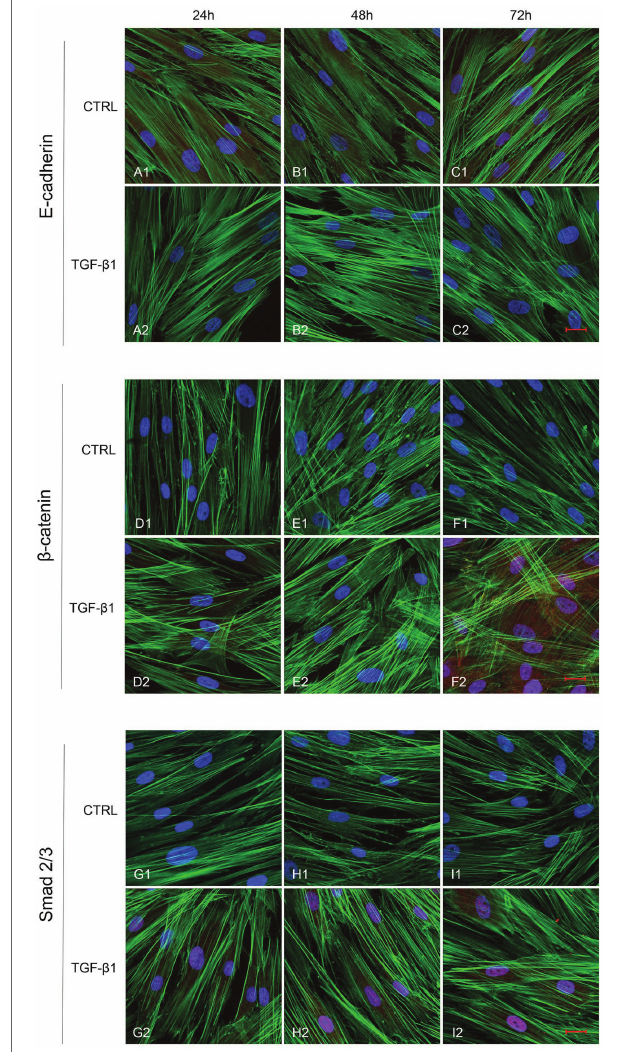
FIGURE 5 | Human GFs uninduced and induced with TGF- β 1 (10 ng/ml) were observed after 24, 48, and 72 h incubation. E-cadherin specific marker evaluation in untreated (A1-C1) and TGF- β 1 treated cells (A2-C2) . β -catenin specific marker evaluation in untreated (D1-F1) and TGF- β 1 treated cells (D2-F2) . Smad 2/3 specific marker evaluation in untreated (G1-I1) and TGF- β 1 treated cells (G2-I2) . Red fluorescence: specific marker; green fluorescence: cytoskeleton actin; blue fluorescence: nuclei. Scale bar: 20 μ m; magnification